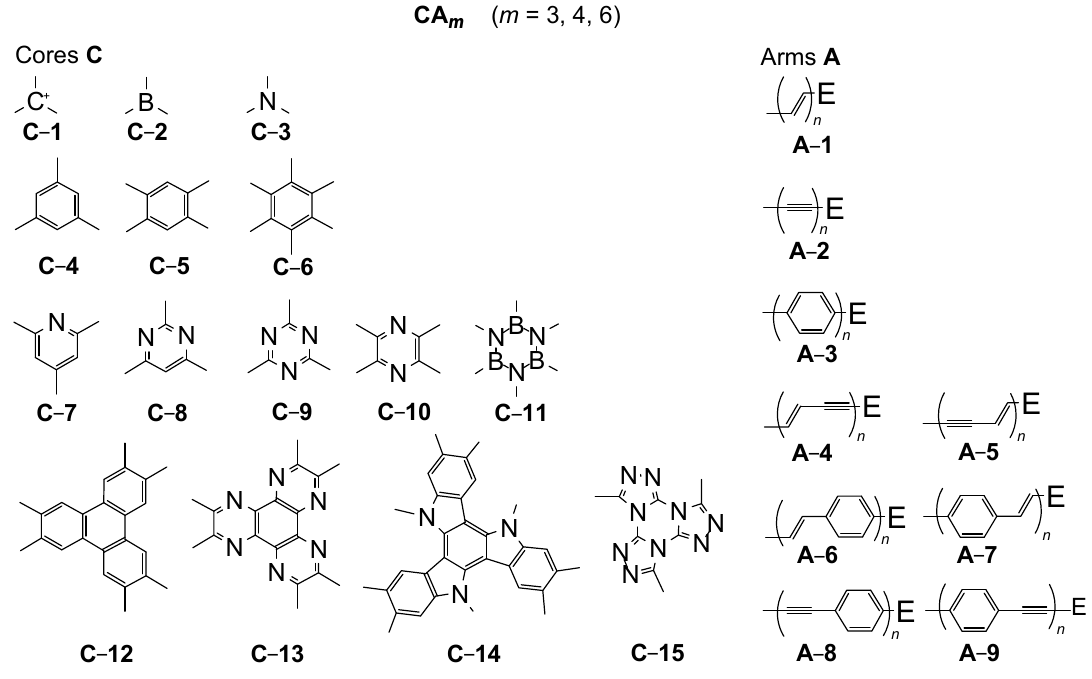
(cores C , arms A m